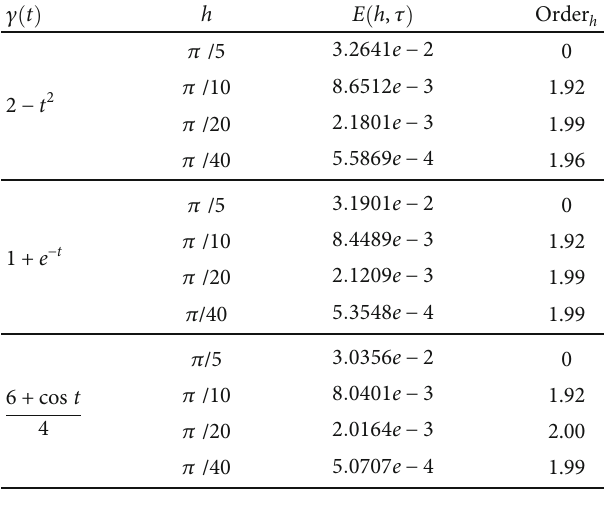
Table 2: Errors and spatial convergence orders, N = 20000